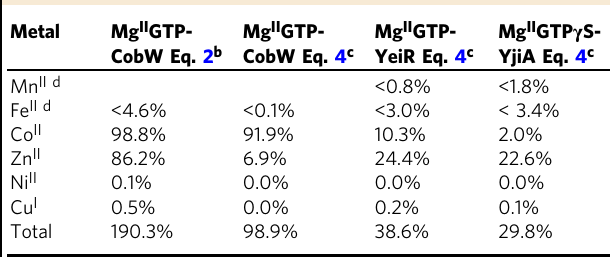
Table 1 Calculated metal occupancies of COG0523 proteins in an idealised cell a